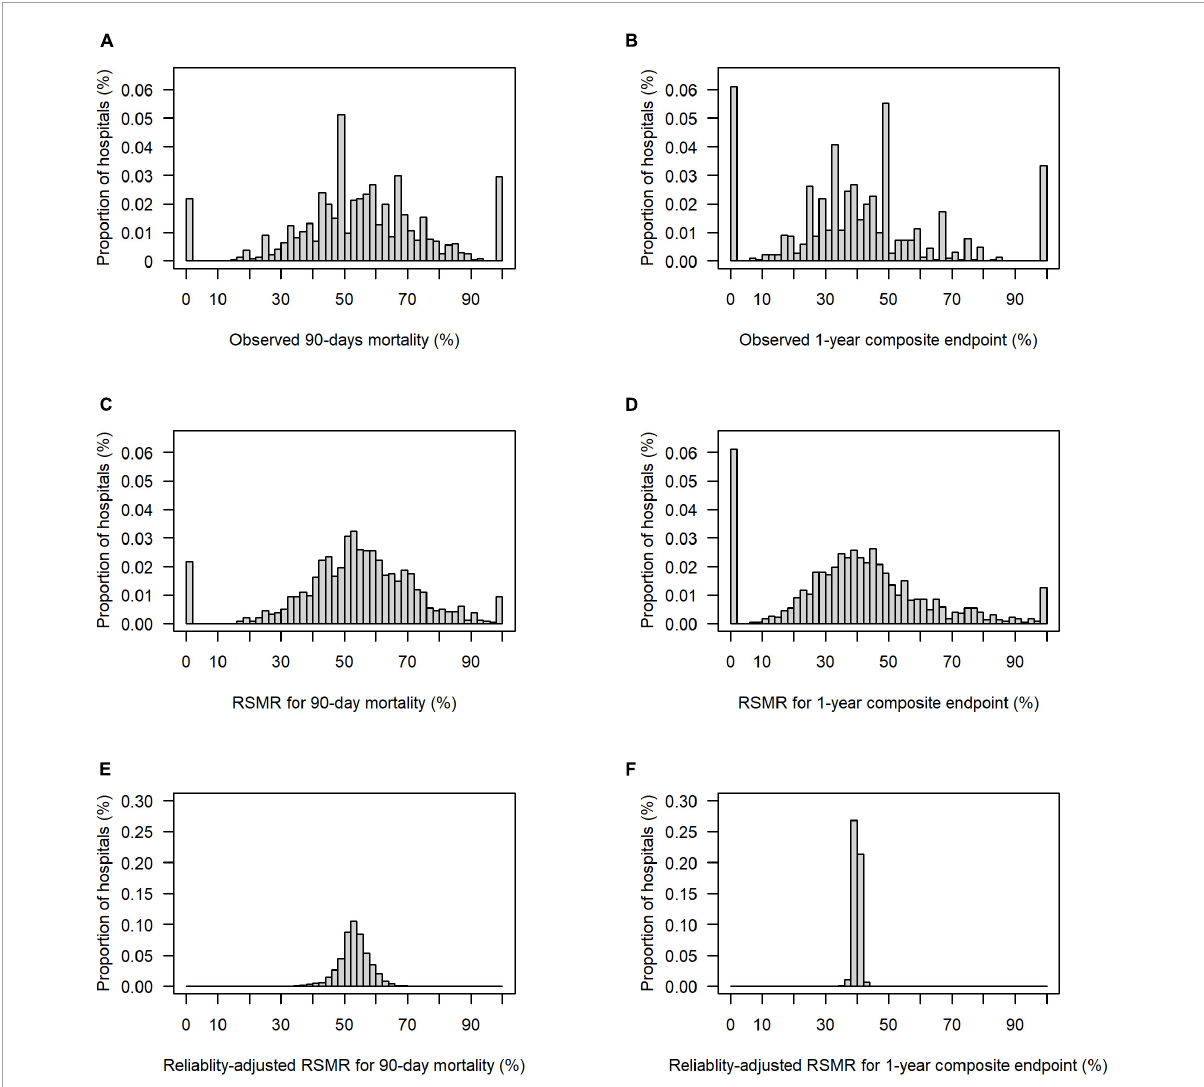
FIGURE2 Distribution of observed, risk-standardized and risk-and reliability adjusted endpoints per hospital. (A) Observed 90-day mortality, range from 0 to 100%, 25th, 50th, and 75th percentile of 44.0, 54.6, and 66.7%, respectively. (B) Observed rate for composite outcome of 1-year-mortality or increased dependency on chronic care, range from 0 to 100%, 25th, 50th, and 75th percentile 26.9, 39.3, and 50.0%, respectively. (C) Risk-standardized rate (RSMR) for 90-day mortality without reliability adjustment, range from 0 to 100%, 25th, 50th, and 75th percentiles of 44.3, 54.2, and 65.5%, respectively. (D) RSMR for the 1-year composite endpoint without reliability adjustment, range from 0 to 100%, 25th, 50th, and 75th percentiles of 27.8, 39.2, and 51.1%, respectively. (E) Reliability-adjusted RSMR for 90-day mortality, range from 35.9 to 68.1%, 25th, 50th, and 75th percentiles of 50.7, 53.2, and 55.9%, respectively. (F) Reliability-adjusted RSMR for 1-year composite outcome, range from 35.8 to 43.3%, 25th, 50th, and 75th percentile of 39.5, 39.9, and 40.4%,